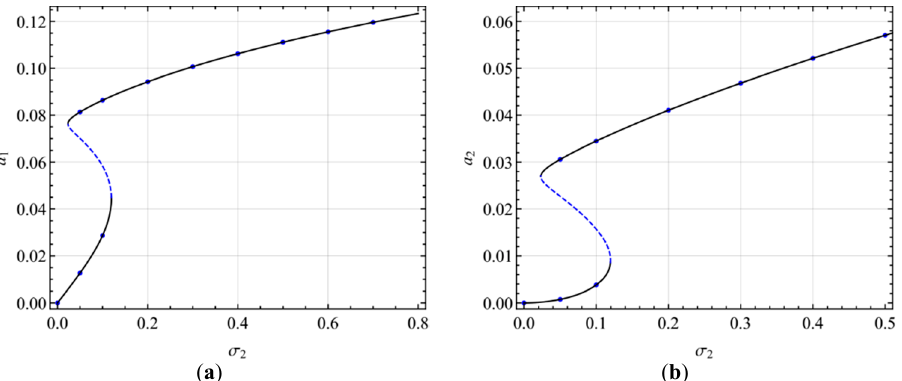
Figure 12. Comparison of the amplitude with forcing amplitude in the case of the primary resonance of the first mode; ( a ) the first mode, ( b ) the second mode.